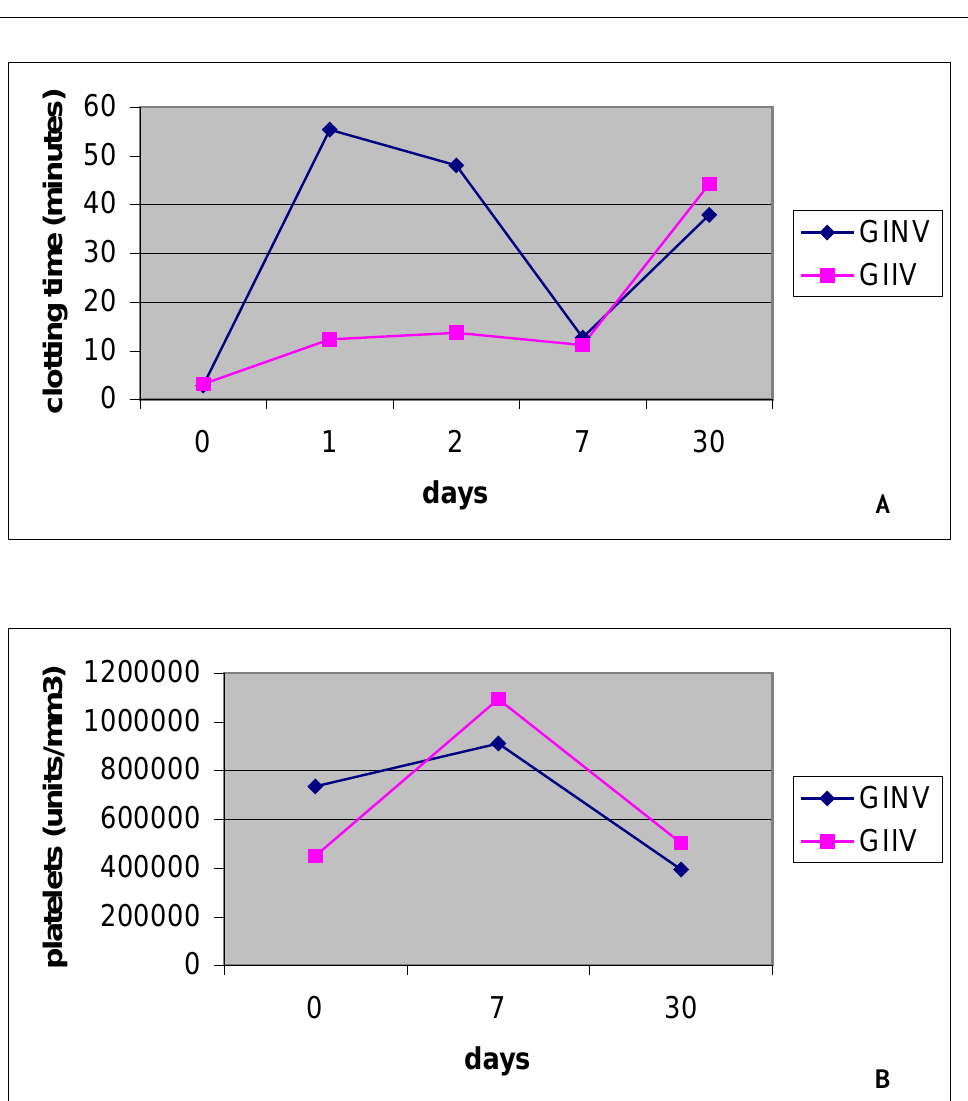
Figure 5. Total blood measurement (A: clotting time, B: platelet count) in animals of the group inoculated with natural venom (GINV) and the group inoculated with irradiated venom (GIIV) before and after venom